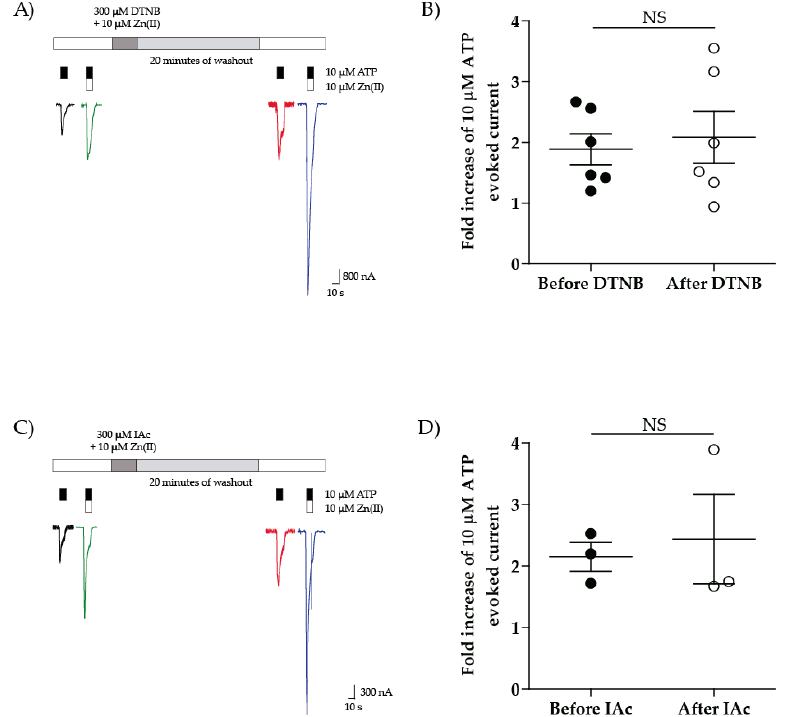
Figure 3. Neither DTNB + Zn(II) nor IAc + Zn(II) treatments abolish the Zn(II) potentiation in rP2 × ( A ) representative traces of ATP-evoked currents in absence (black) and presence of Zn(II) (Green) and after DTNB + Zn(II) treatment (red and blue) and ( B ) quantification of the fold increase of